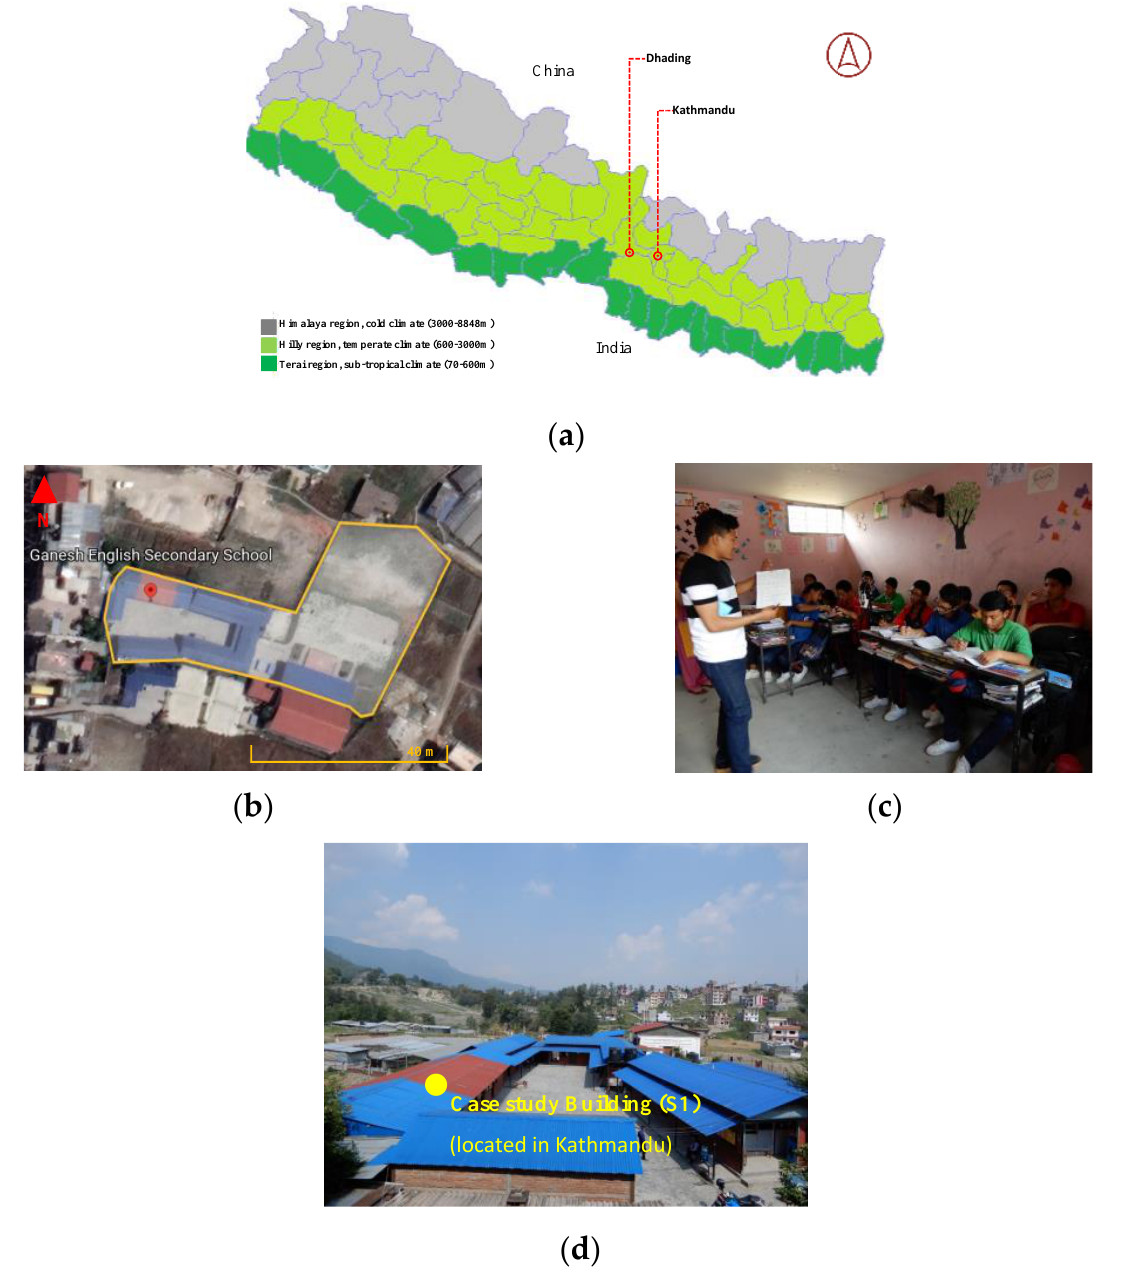
Figure 2. ( a ) Location of the study area; ( b ) satellite image of the case study school building (S1); ( c ) internal view of the case study classroom, which is represented by zone 3 during the simulation; and ( d ) external view of S1. The building S1 is elevated above sea level at 1345 m and has a temperate climate. The location of the school building is 27.77348° N and 85.33081° E.